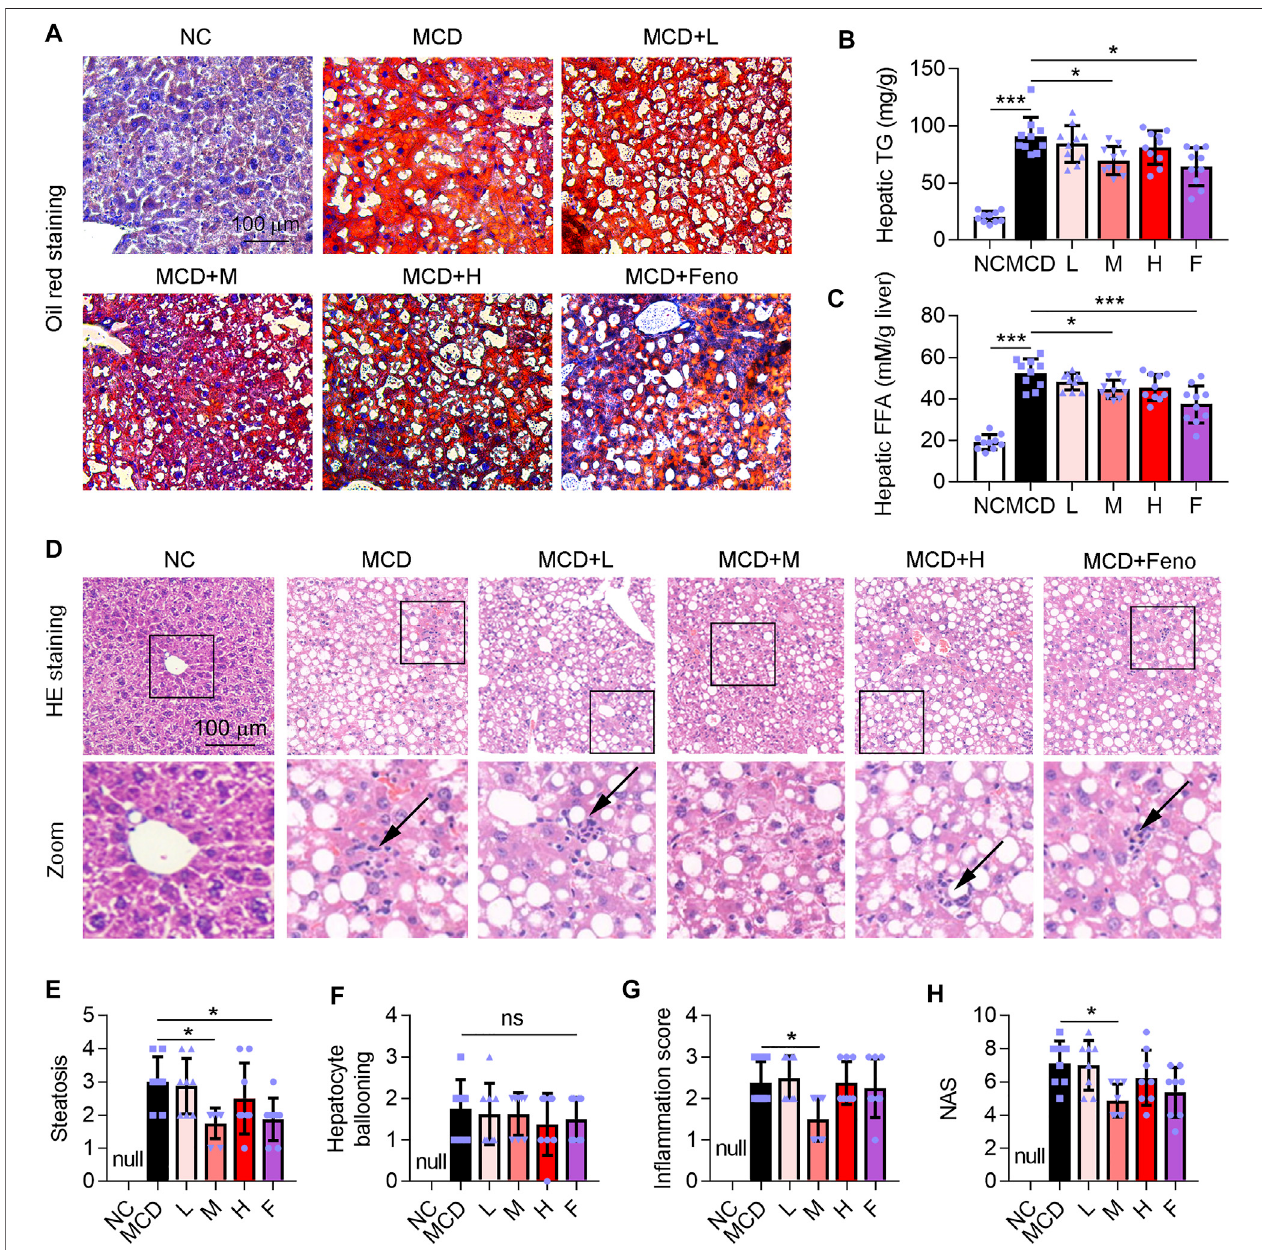
FIGURE 4 | Ganweikang tablet alleviates steatosis in the liver of MCD-fed mice. (A) Representative images of oil red O staining on the liver sections. (B,C) Hepatic TG and FFAin differentgroups weredetectedbythekit. (D) Representativeimages ofHE staining ontheliver sections from theindicated groups. (E – H) Afteranalysisof HE staining, the changes in steatosis (E) , hepatocyte ballooning (F) , in fl ammation score (G) , and NAS (H) between the groups are shown in the fi gure. * p < 0.05, *** p < 0.001, by one-way ANOVA with Bonferroni correction. ns, no signi fi cance.